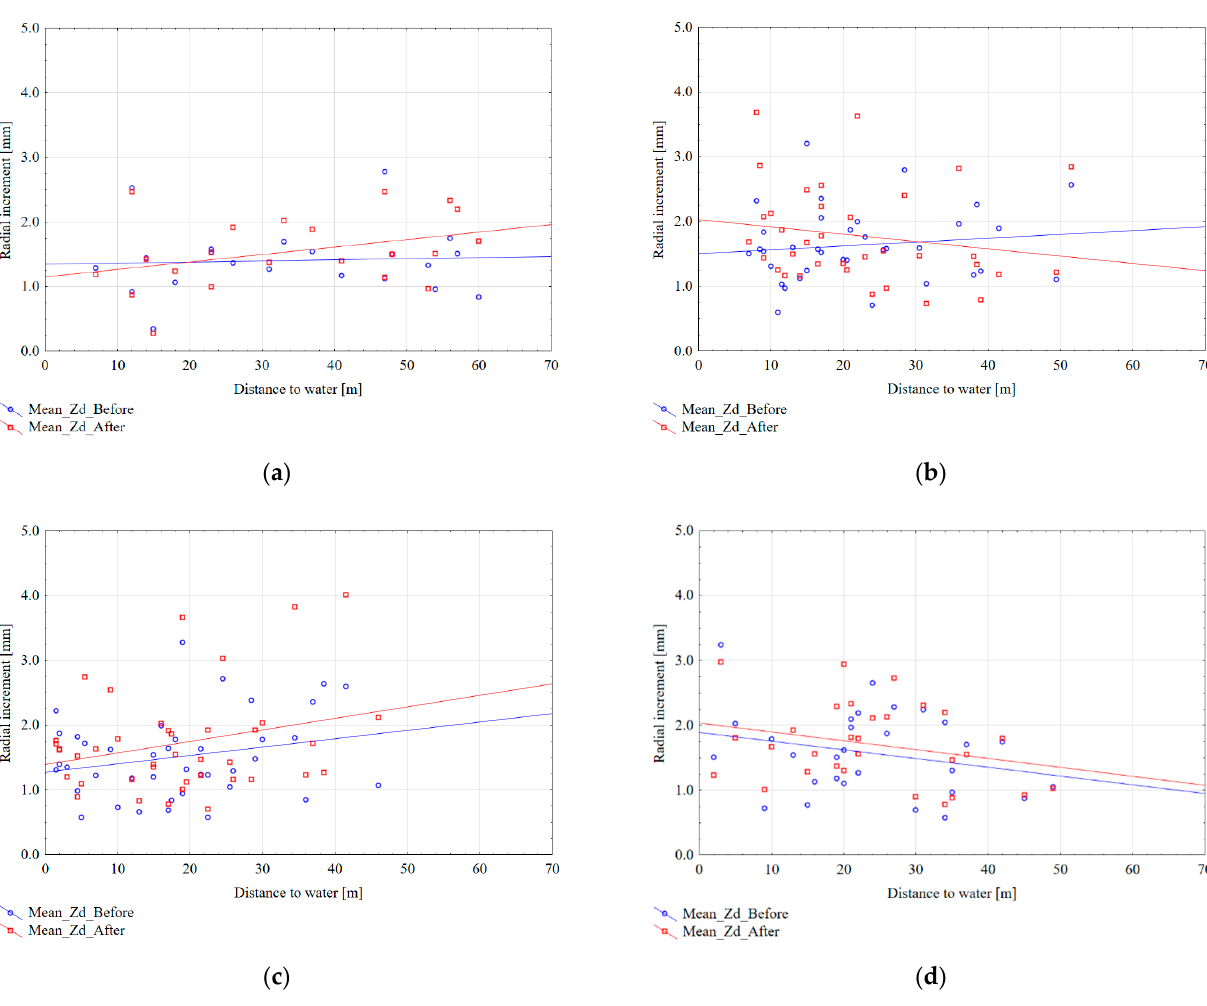
Figure 4. Average values of increments before (Zd_Before) and after (Zd_After) construction of hydrotechnical facilities depending on the distance in the Maskuli ń skie ( a ), Soko ł ów ( b ), Celestynów ( c ) and Bi ł goraj ( d ) forest districts. Table 5. Regression (r²) and statistical significance ( p ) of Scots pine radial increments before (Zd_Before) and after (Zd_After) construction of hydrotechnical facilities, depending on the dis- tance.